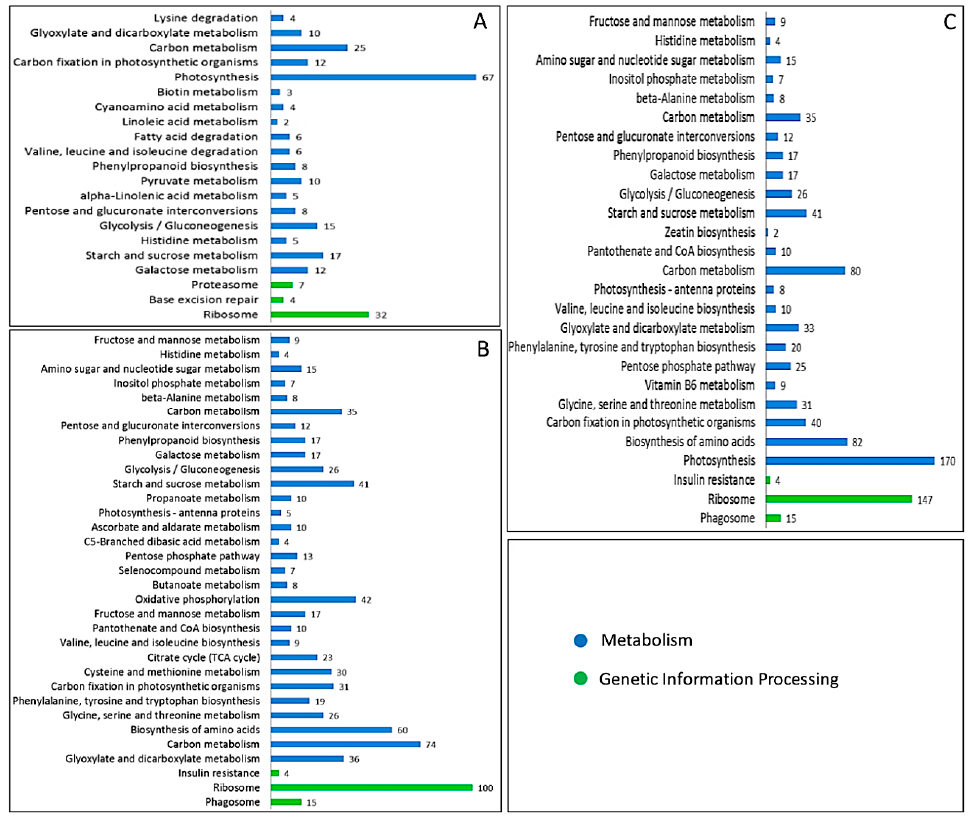
Figure 5. Main DAPs enriched in the top 20 pathways in UNP ( A ), BNP ( B ), and TNP ( C ). Table 1. Significantly enriched differentially abundant proteins in the three stages.